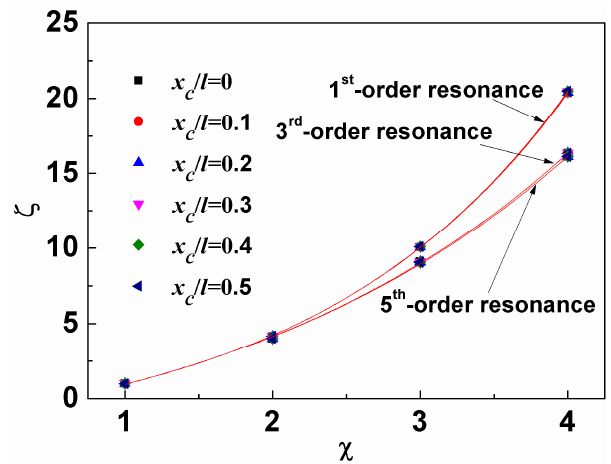
Figure 5. R sm ratio ( ζ ) as the function of viscous damping coefficient ratio ( χ ).